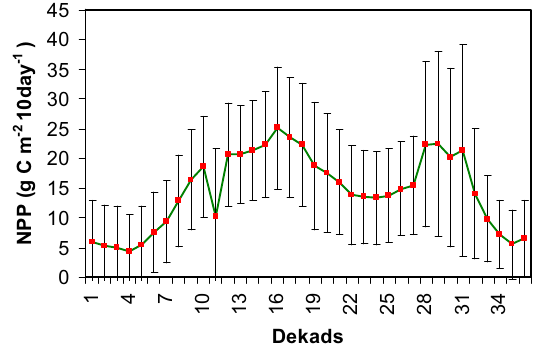
Fig. 3.Seasonal variation in modeled estimates of mean NPP over cropland in India. Bar shows ± standard deviation